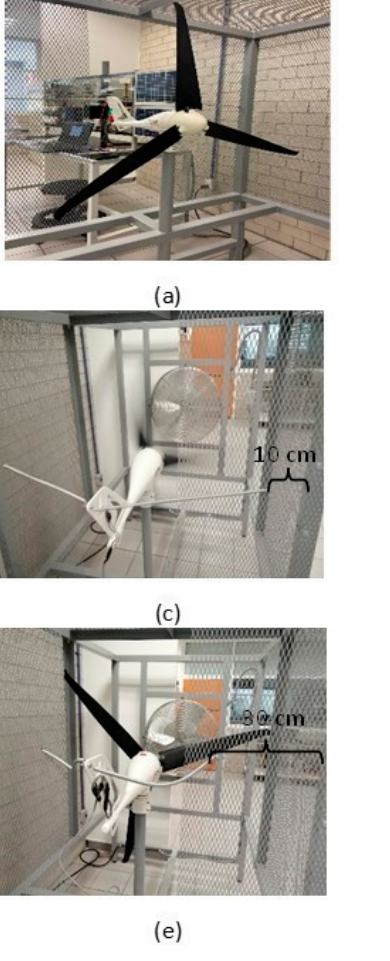
Figure 1. ( a ) Sunforce 400 W wind turbine in laboratory; ( b ) wind turbine support spring at 4 cm; ( c ) wind turbine support spring at 10 cm; ( d ) wind turbine support spring at 20 cm; ( e ) wind turbine support spring at 30 cm; ( f ) wind turbine in operation.